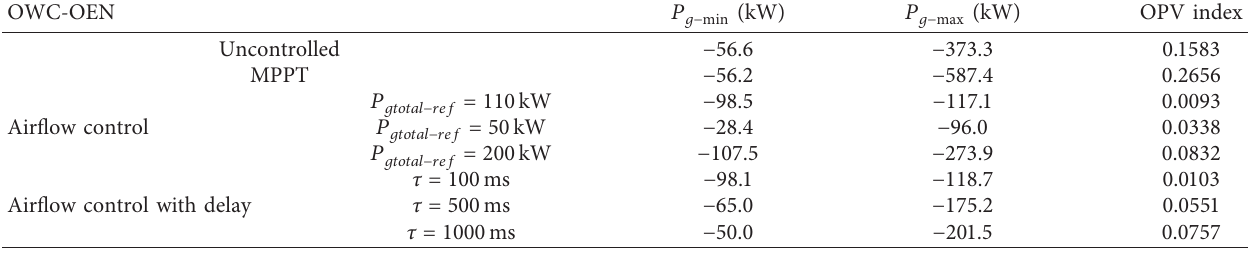
Figure 13: OWC-OEN output power and error waveforms with centralized airflow controller. (a) P � − 110kW, and (c) P � − 200 kW. (b) P g g total − ref total − ref Table 5: OPV index values of OWC-OEN.